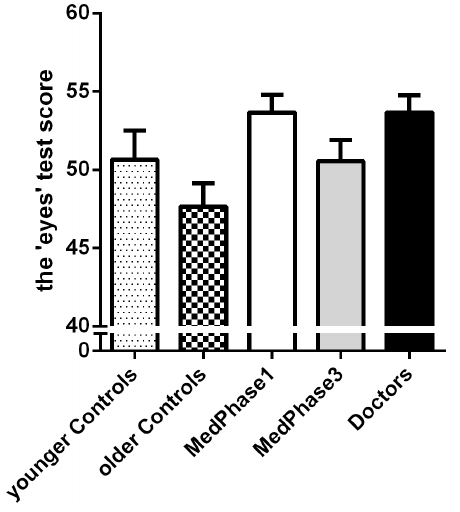
Figure 3. Mean scores for the ‘‘eyes’’ test for the five participant groups. Error bars represent the standard error of the mean.